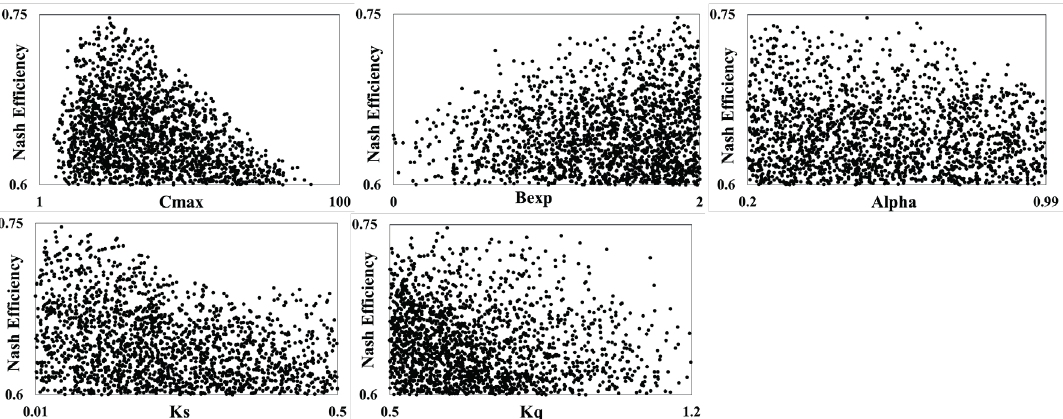
Fig. 2 Scatter plots of five parameters values versus likelihoods for the behavioural parameter sets.